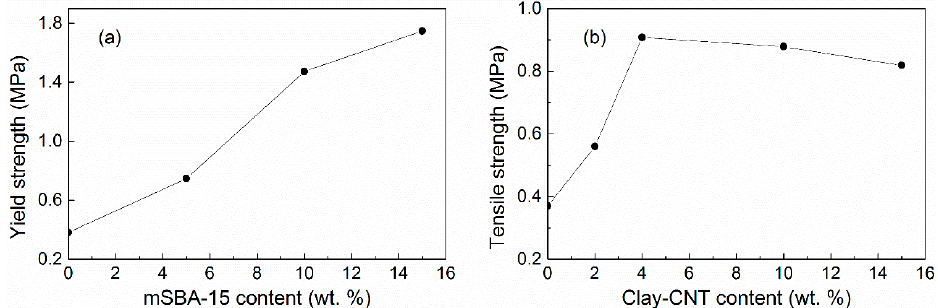
Figure 17. ( a ) Tensile stress–strain curves for PEO (300,000 g/mol)–LiClO 4 –mSBA (silane-functionalized mesoporous silica) CPE films with various amounts of mSBA-15; the inset shows their yield strength (room temperature). Data from Wang et al. [169]; ( b ) Tensile strength with varying hybrid filler content; the inset shows stress − strain curves of pristine PEO and PEO (100,000 g/mol)–LiClO 4 –(montmorillonite–CNT) samples with varying filler content. Data from Tang et al. [171].